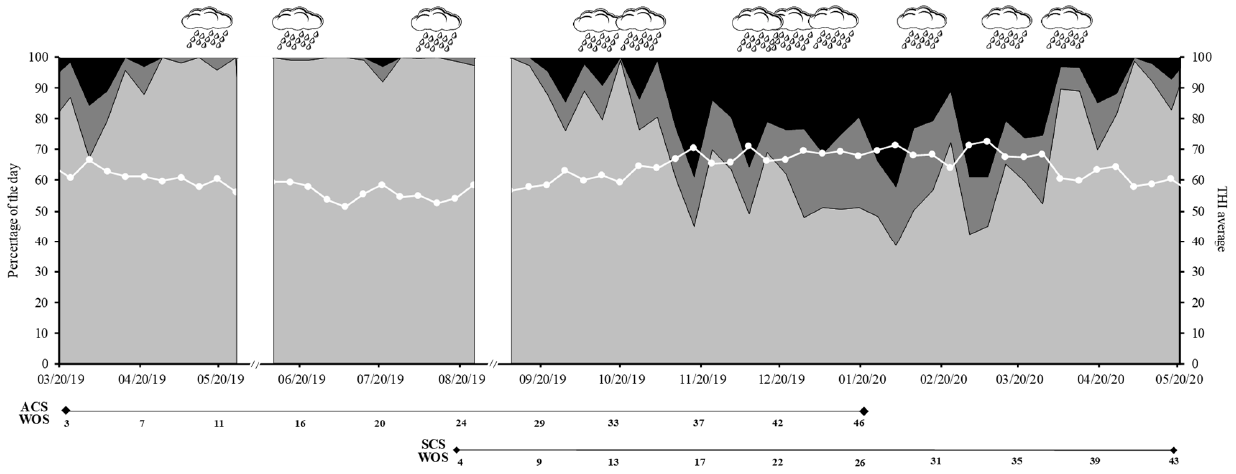
Figure 1. Percentage of the day in which a temperature humidity index (THI) was observed that was less than 68 ( ), between 68 and 72 ( ), and higher than 72 ( ). The continuous white line with dots indicates the THI weekly average. Cloudy icons indicate moments of heavy rain (>50 mm per week during consecutive weeks or >80 mm in a week). There were no records during part of May and August 2019 due to technical problems at the meteorological station (blank spaces).